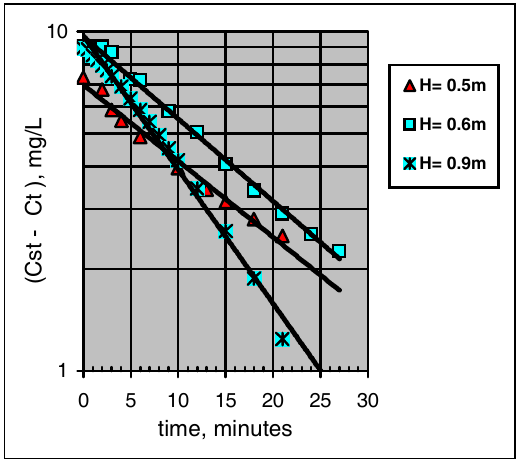
Figure 4: Sample of the experimental results showing the – C ) over time at various water variation of log (C st t